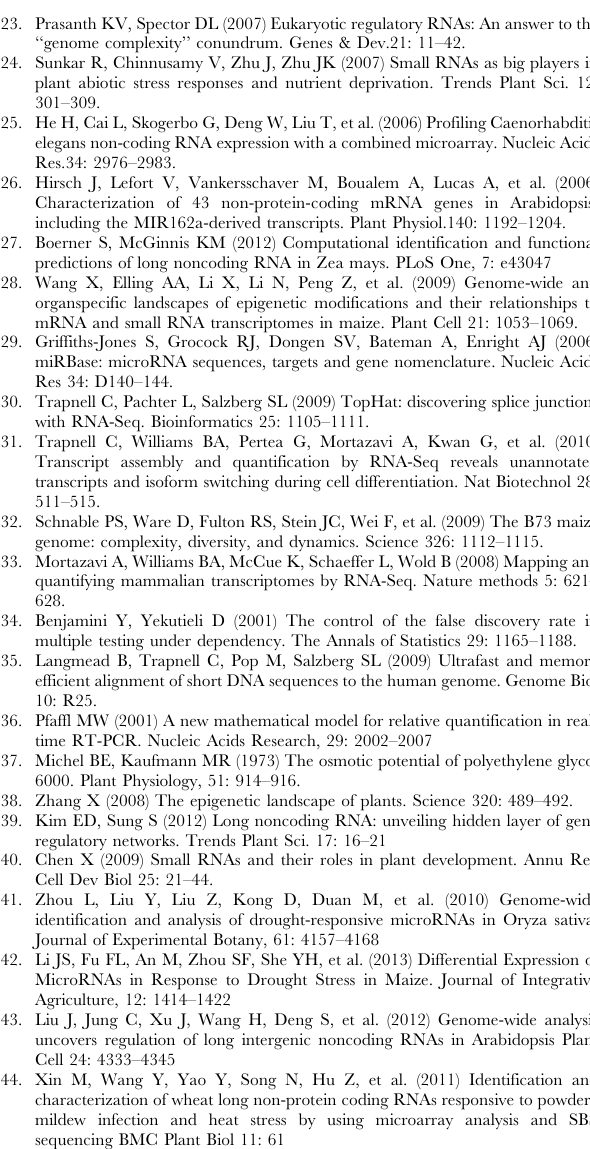
Table S3 The lncRNAs were homologous to known lncRNAs in maize. (XLS) Table S4 The lncRNAs had homology with shRNA reads. Table S5 The lncRNAs had homolgy with siRNA reads. Table S6 The tissue specific expression of 57